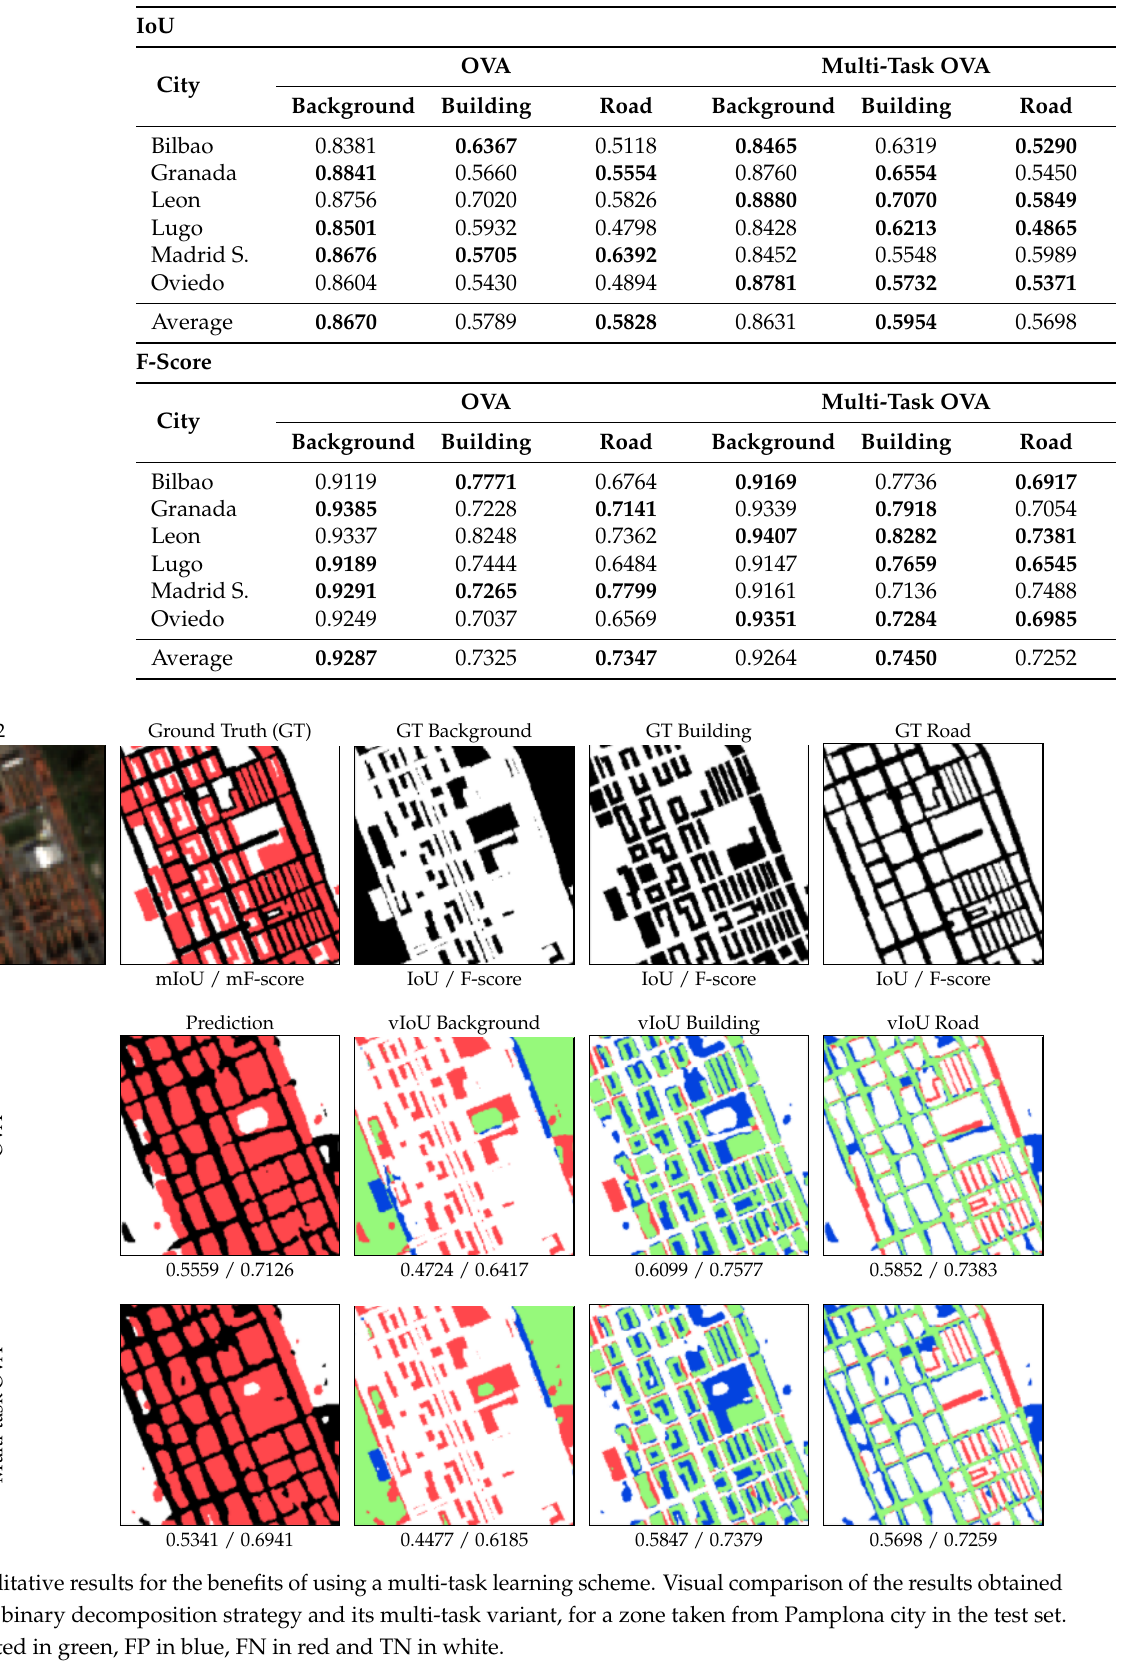
Table 3. Results obtained in terms of IoU and F-score metrics, in the testing set for Experiment 2.